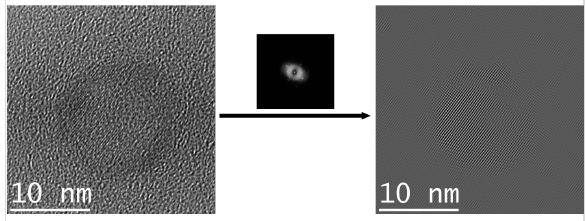
Figure 6: TEM image of a cerium oxide particle (left) with the corres- ponding diffractogram (middle) and a filtered image for better visibility of the lattice fringes (right).